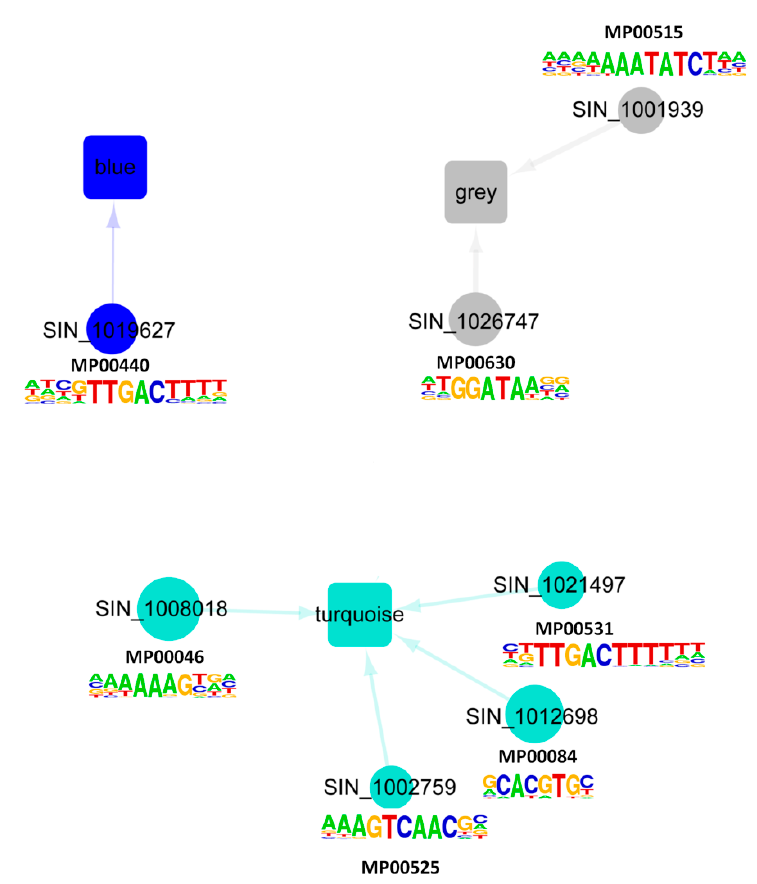
Figure 4. Predicted directional interactions of TFs and the co-expressed modules in the sesame CARGs. Network plots of inferred connections between TF and genes in the three modules. The promoter sequences of genes associated with each module were tested for overrepresentation of DNA motifs shown to be bound to TFs that are di ff erentially transcribed following stress treatments. Each TF with a known motif is represented by a colored circle corresponding to its appertaining module. The di ff erent modules are represented by a rectangle. An edge between a TF and a module indicates significant enrichment of the corresponding binding motif in that module. The size of each TF node is proportional to the number of predicted regulated downstream genes. Logos of the seven enriched DNA binding motifs within the promoter regions of the genes belonging to each module detected by WGCNA were added.